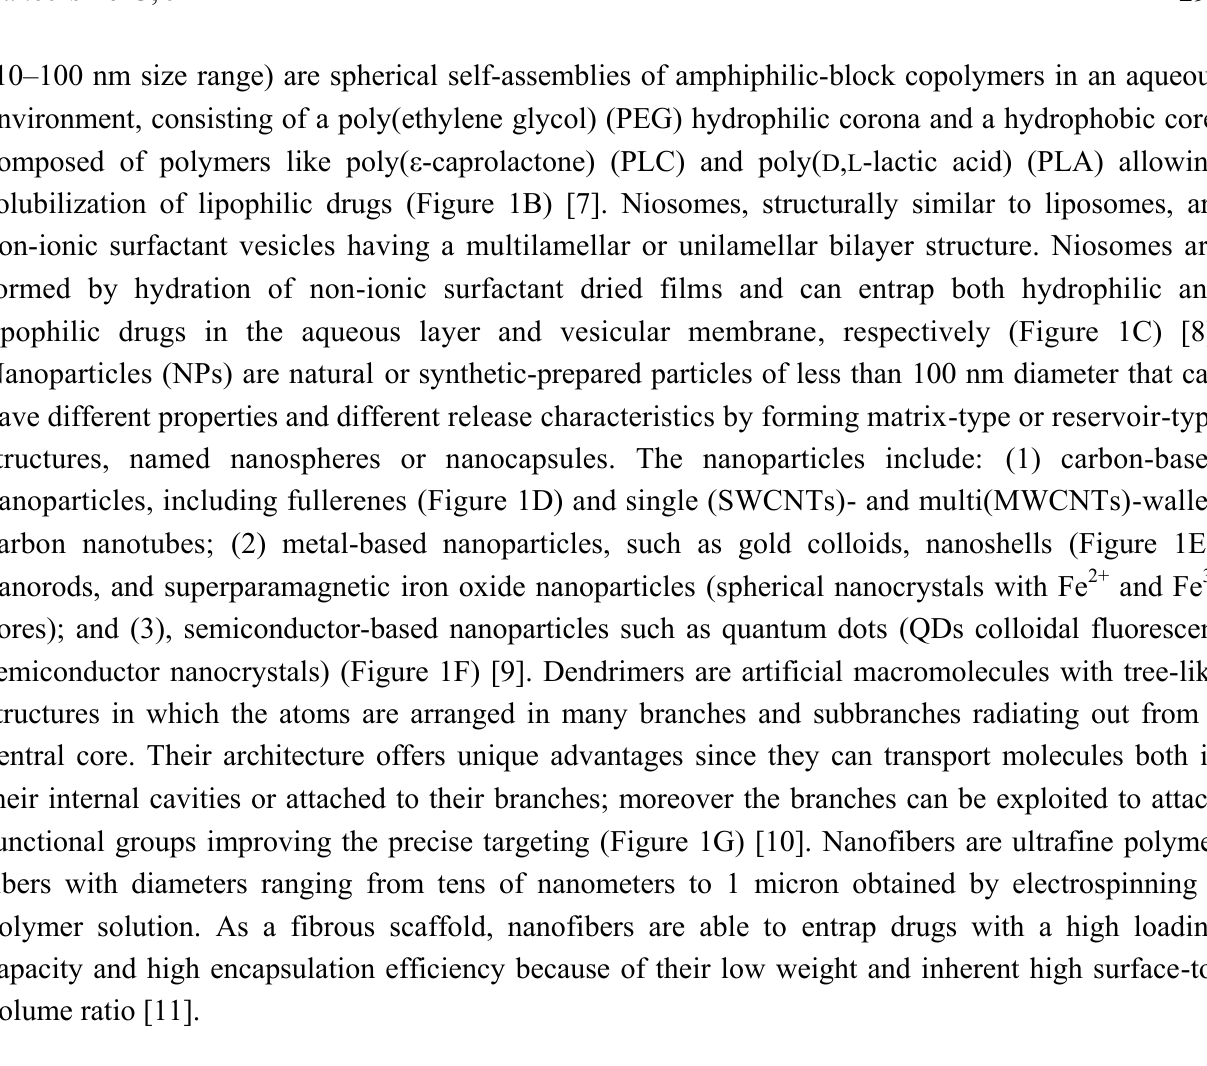
Figure 1. Drug delivery nanoparticle systems: ( A ) liposome; ( B ) micelle; ( C ) niosome; ( D ) fullerene; ( E ) nanoshell; ( F ) quantum dot; ( G )